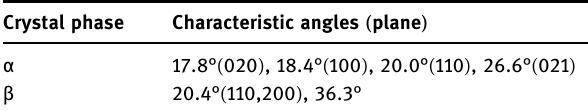
Table 4: Characteristic angles of α - phase and β - phase in PVDF and its copolymers [ 38 – 40 ]